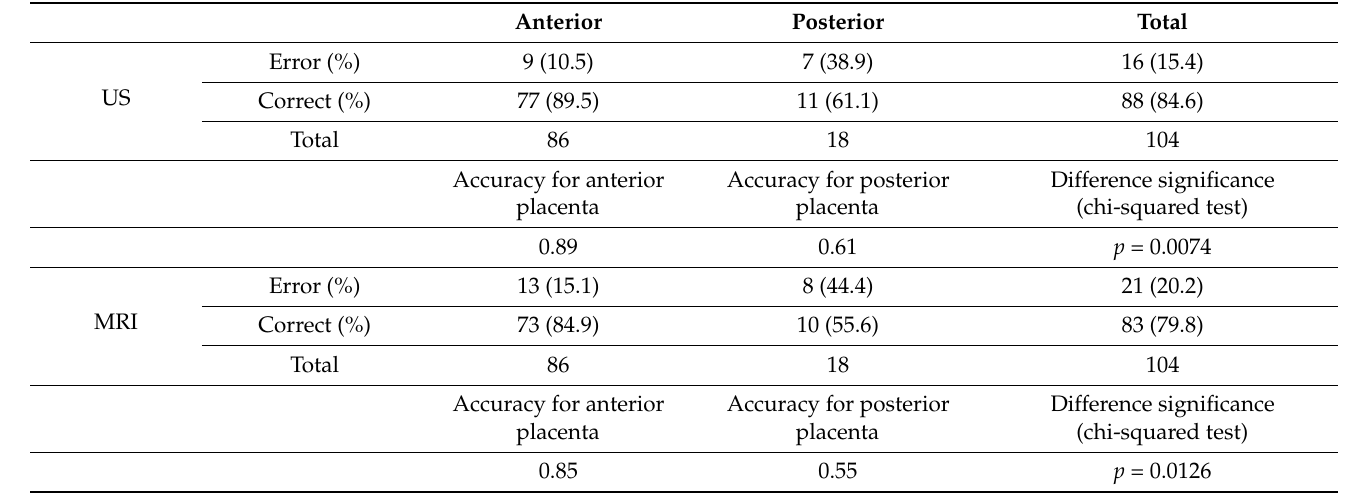
Table 7. US and MRI: PAS degree’s distinction according to the placental